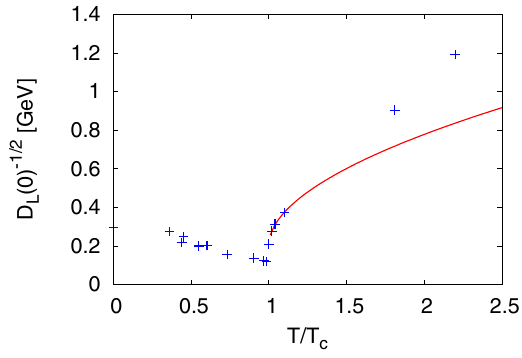
Fig. 2. Displayed is the Landau gauge chromoelectric screening mass scale with a fit to the critical exponent near the critical point. The data points are taken from Ref. [51].